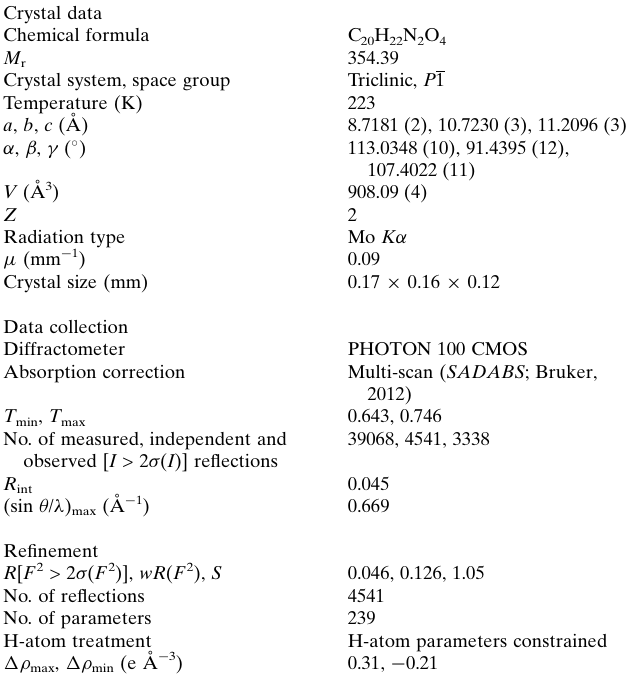
Table 2 Experimental